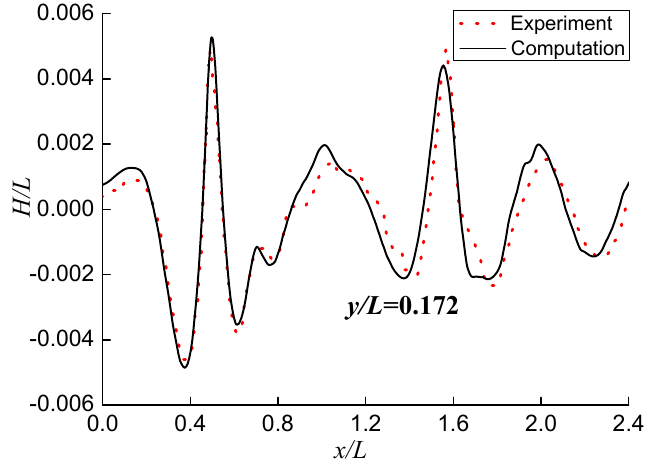
Figure 8. Comparison of wave elevation at y/L = 0.172 longitudinal section obtained by computation and experiment for intact